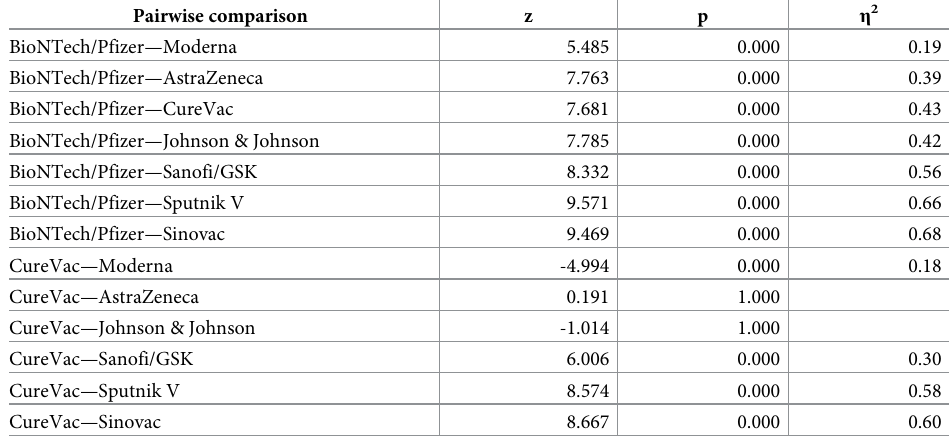
Table 1. Pairwise Wilcoxon signed-rank comparisons with German COVID-19 vaccines for significant Friedman test. Pairwise